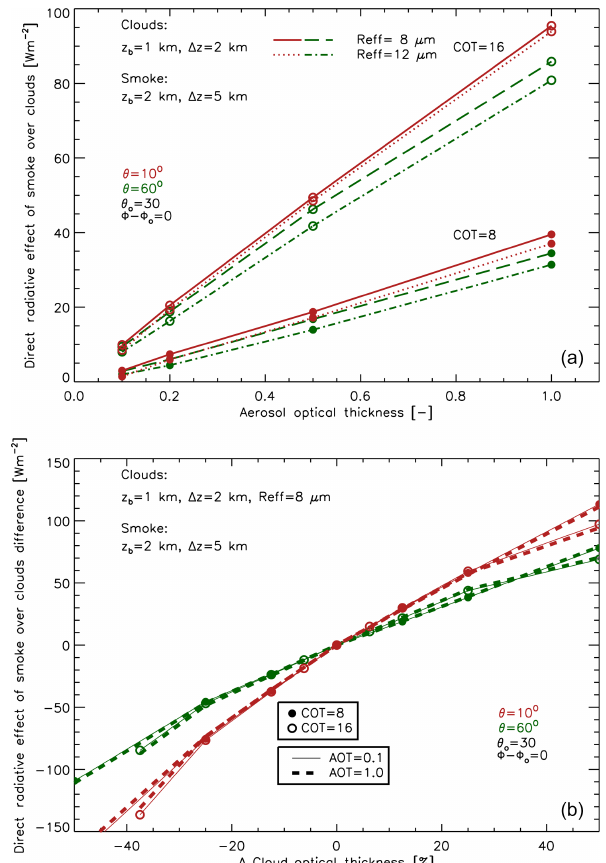
Figure 5. (a) Aerosol DRE for simulated scenes with clouds be- tween 1 and 2km and smoke aerosol between 2 and 5km as a func- tion of AOT at 550nm. The COT was 8 or 16 and the effective cloud droplet radius 8 or 12µm. SZA was 30 ◦ , VZA was 10 ◦ or 60 ◦ , and RAZI was 0 ◦ . (b) Aerosol DRE for simulated scenes as in (a) , as a function of relative error in the retrieved